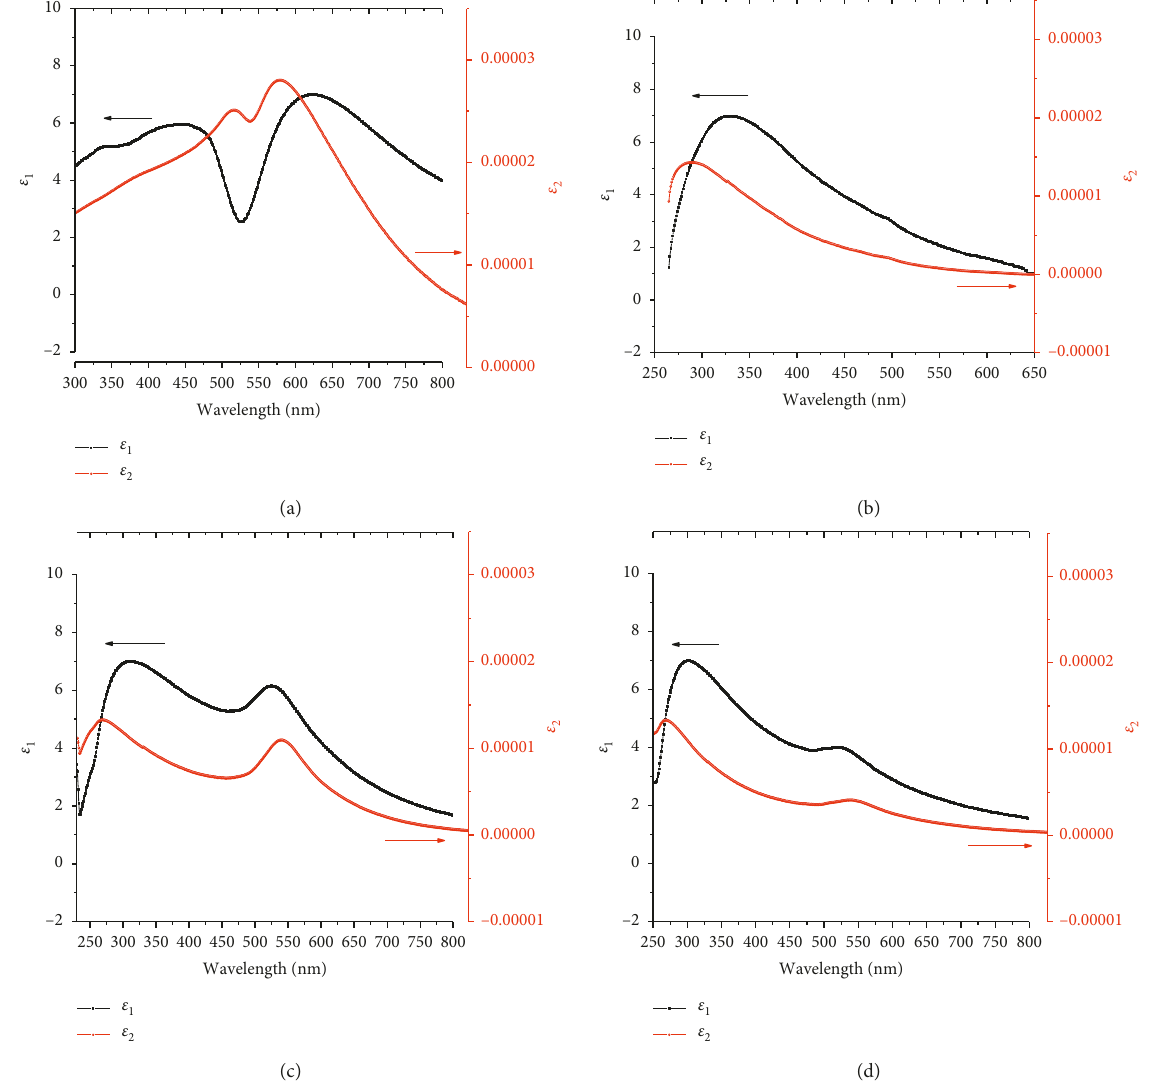
Figure 7: The relationship between ε 1 and ε 2 with wavelength in the PVP